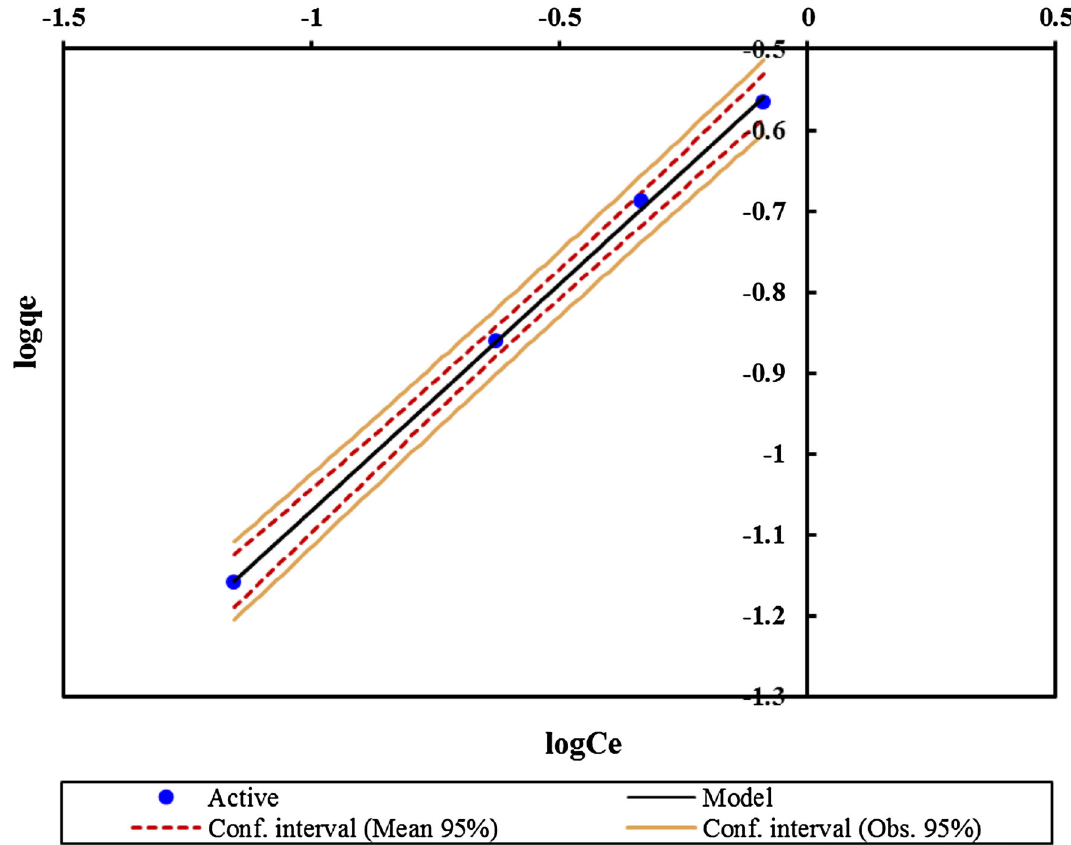
Fig. 2 Freundlich isotherm obtained using the linear method for the sorption of fluoride onto